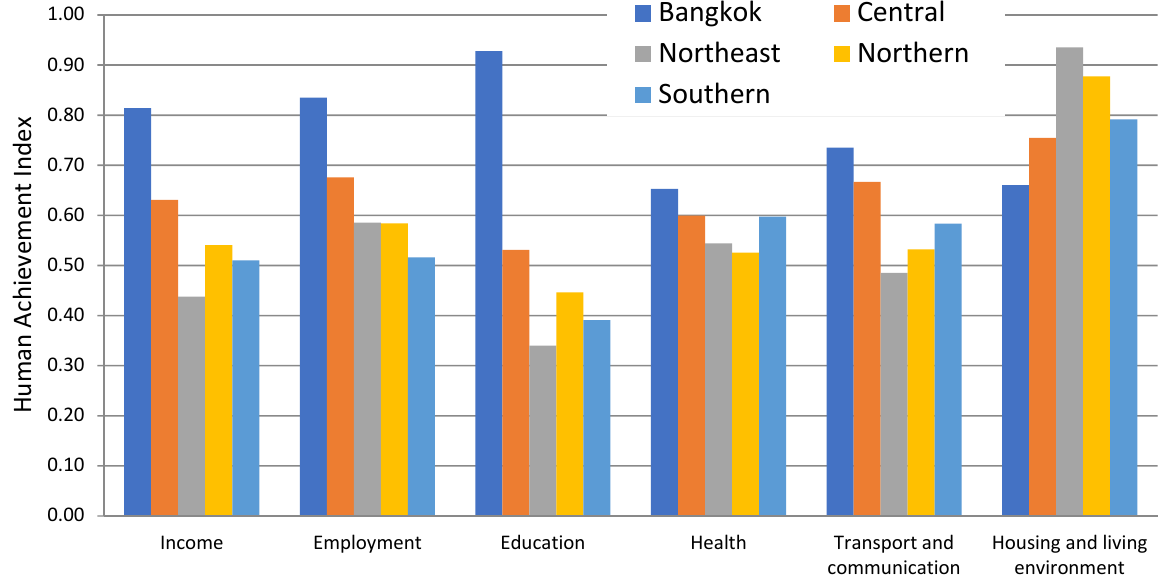
Figure 2. The Human Achievement Index in 2017. Source: NESDC (2017). Note: The Human Achievement Index value ranges from 0 (worst outcome) to 1 (best outcome).